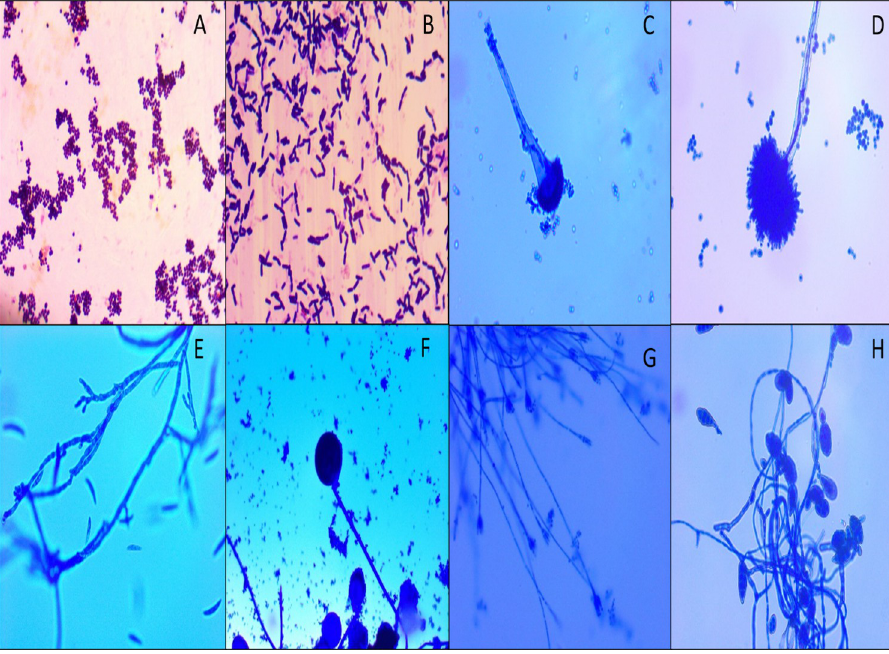
Fig 4. Photomicrographs of dominant indoor microflora. A. G+ Cocci (1000X), B. G+ Bacilli (1000X), C. Aspergillus (400X), D. Aspergillus (400X), E. Fusarium (400X), F. Rhizopus (400X), G. Penicillium (100X), H. Alternaria